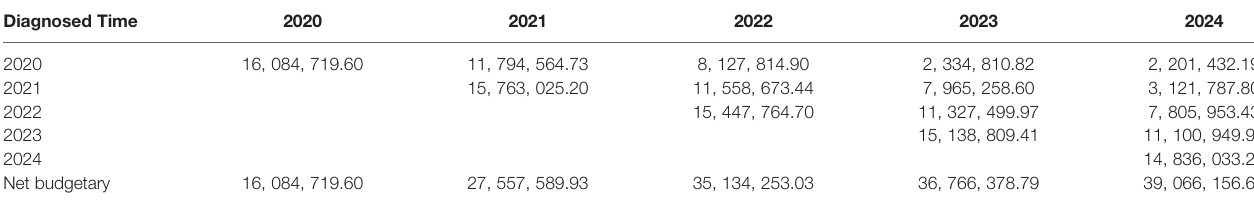
TABLE 3 | Incremental expenditure